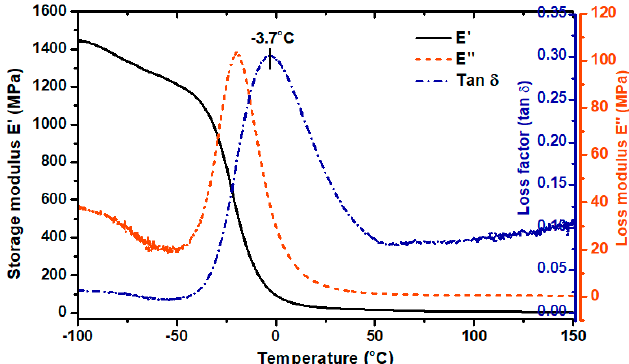
Figure 6. Dynamic mechanical analysis DMA results of TPU printout. Storage modulus (E’), loss modulus (E’’), loss factor (Tan δ ). modulus (E”), loss factor (Tan δ